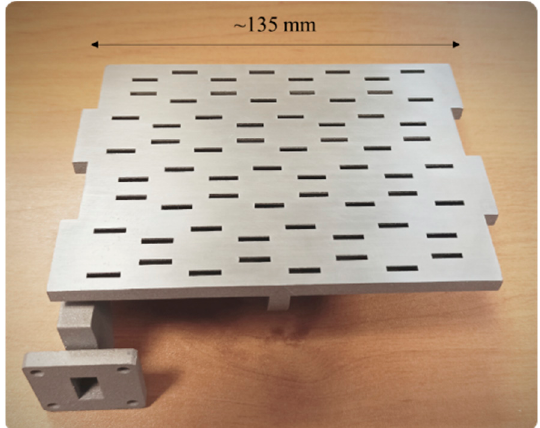
Figure 13. Photograph of the SWA array realized by the DMLS process.